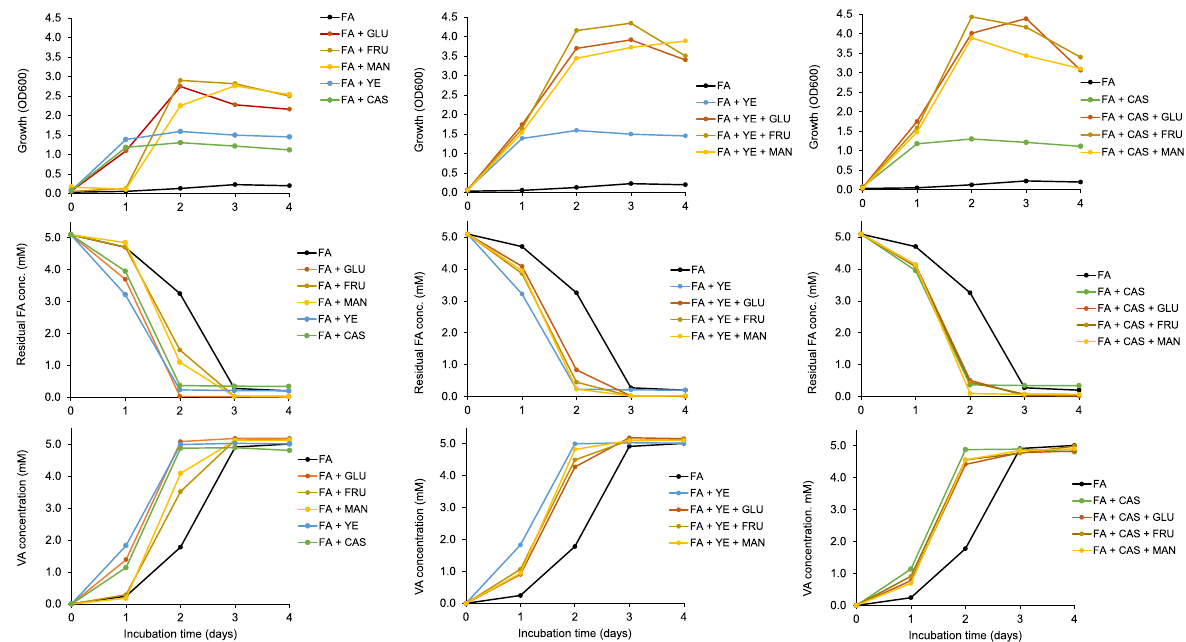
Fig. 6 Effect of supplementation of MM with (0.3% w/v) glucose (GLU), fructose (FRU), mannose (MAN), yeast extract (YE), and casamino acids (CAS) (right panels); YE in combination with monosaccharides (middle panels), or CAS in combination with monosaccharides (right panels) on growth (top panels), 5 mM FA degradation (middle panels), and VA production (bottom panels) by P. aromaticivorans AR20-38 at 20 °C. Data represent mean values of three replicates (SDs < 10%)